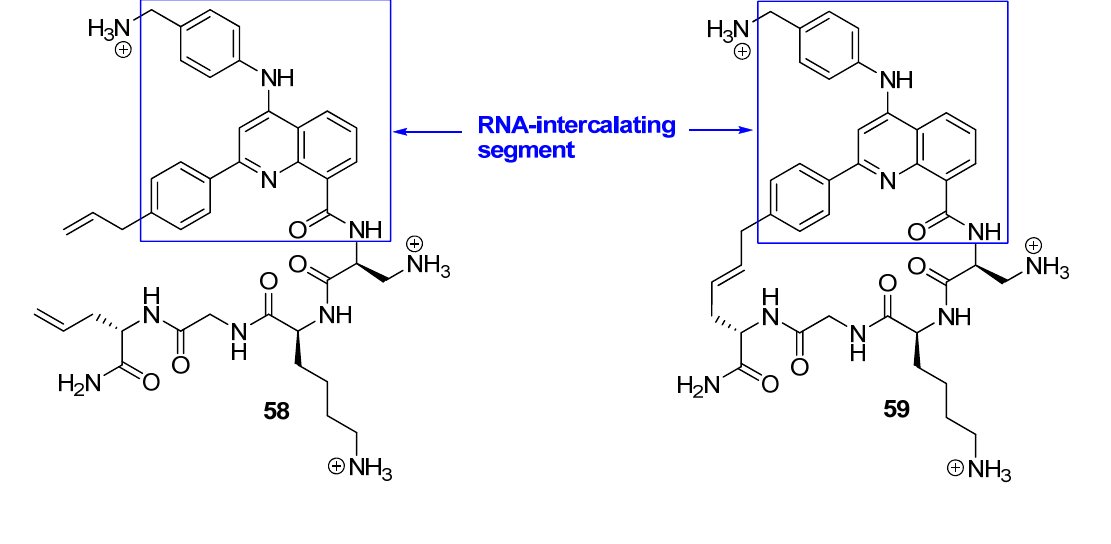
Figure 16. Macrocyclization of the helix-threading peptide 58 affords a higher affinity